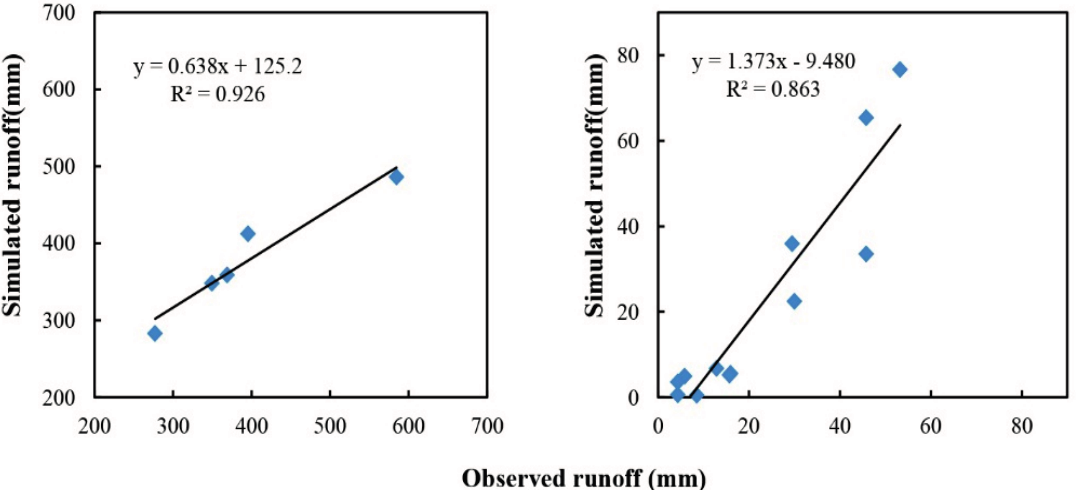
Figure 3. Comparison between observed and simulated runoff at annual ( left ) and monthly ( right ) scales for calibration